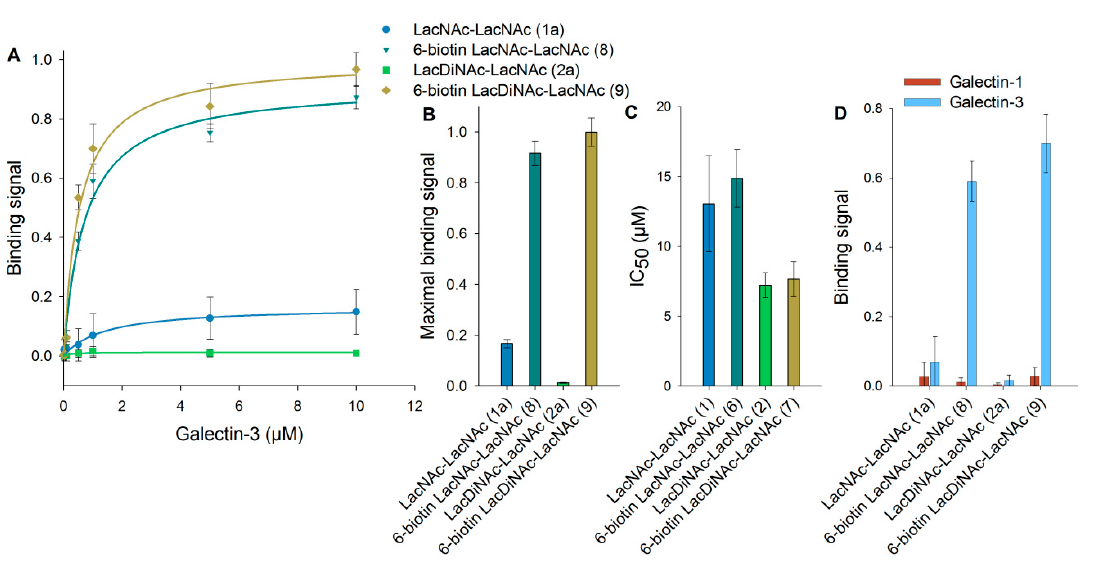
Figure 2. Influence of 6-biotinylation of tetrasaccharides LacNAc-LacNAc and LacdiNAc-LacNAc on galectin binding and inhibition. Binding curves ( A ) and maximal binding signals ( B ) of Gal-3 to immobilized glycans show differences between biotinylated and non-biotinylated ligands. In competitive inhibition assays, the inhibitory potency was not affected by C6-biotinylation of the tetrasaccharides ( C ). Comparison of Gal-3 and Gal-1 at a 1 µM protein concentration indicates high specificity of biotinylated tetrasaccharides towards Gal-3 ( D